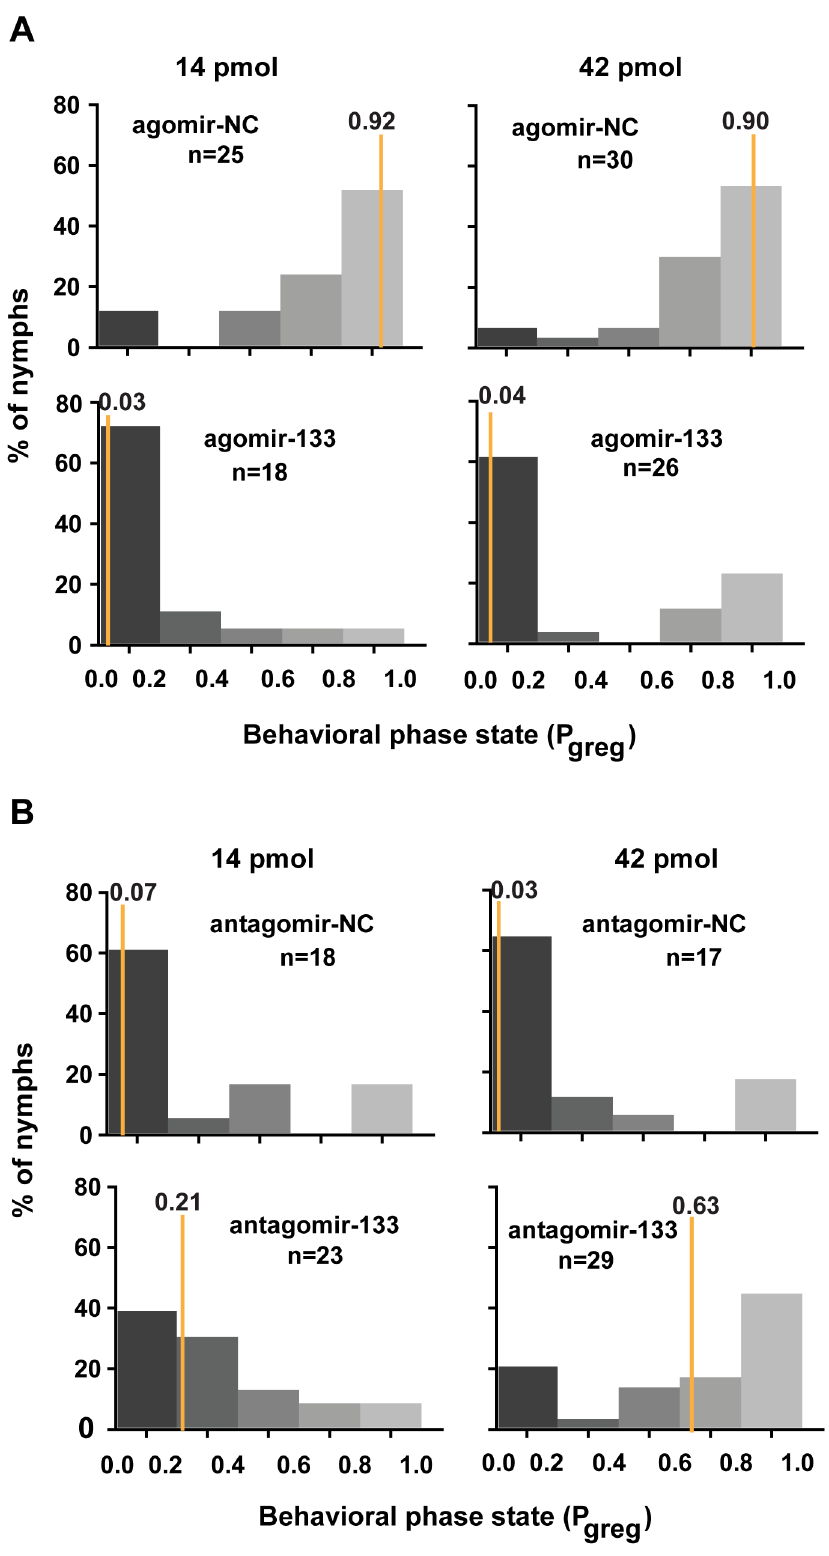
Figure 5. miR-133 fosters the phase transition phenotype of the migratory locust. (A) The effects of 14 or 42 pmol agomir-133 treatment on the behavior of gregarious locusts were studied 48 h after injection. (B) The effects of 14 or 42 pmol antagomir-133 treatment on the behavior of solitary locusts were studied 48 h after injection. P greg , probabilistic metric of gregariousness. The vertical lines indicate the median P greg values. P greg =1 indicates fully gregarious behavior, and P greg =0 indicates fully solitary behavior.